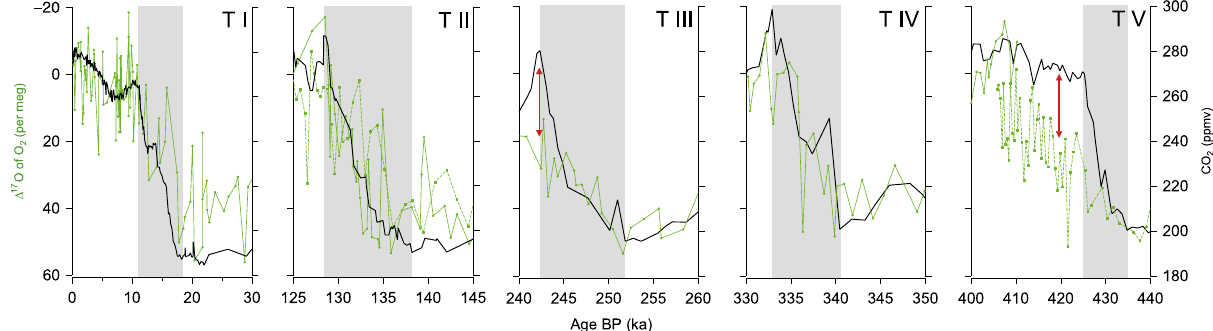
Fig. 2 Comparison of CO 2 and Δ 17 O of O 2 evolutions over the last fi ve terminations. CO 2 69 (black); Δ 17 O of O 2 combining new data (Termination II and Termination V, dotted green line) and data from Blunier et al. 21,22 (solid green line). The red arrows indicate the strongest differences between the CO 2 and Δ 17 O of O 2 evolutions during interglacial periods. The grey shadow bars correspond to the main increase in atmospheric CO 2 over